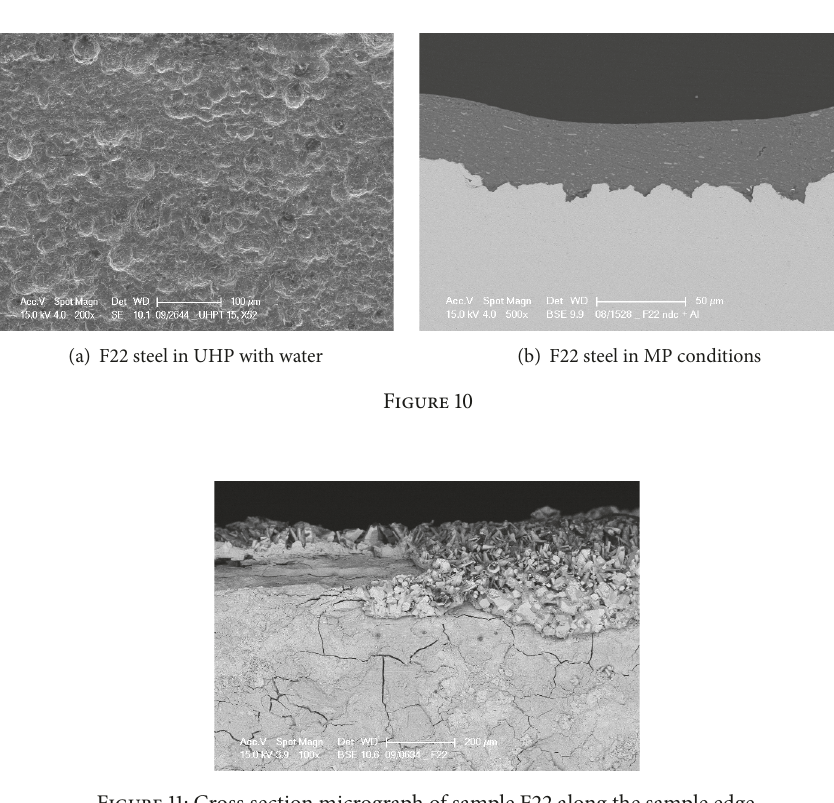
Figure 11: Cross section micrograph of sample F22 along the sample